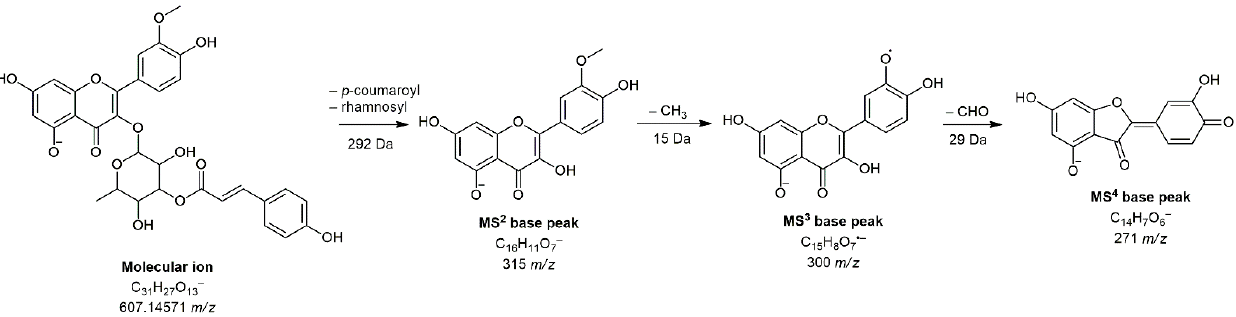
Figure 1. Schematic representation of fragmentation of compound 31 (kaempferol 3- O -(2 ″ ,3 ″ -di- p -coumaroyl)-rhamnoside).